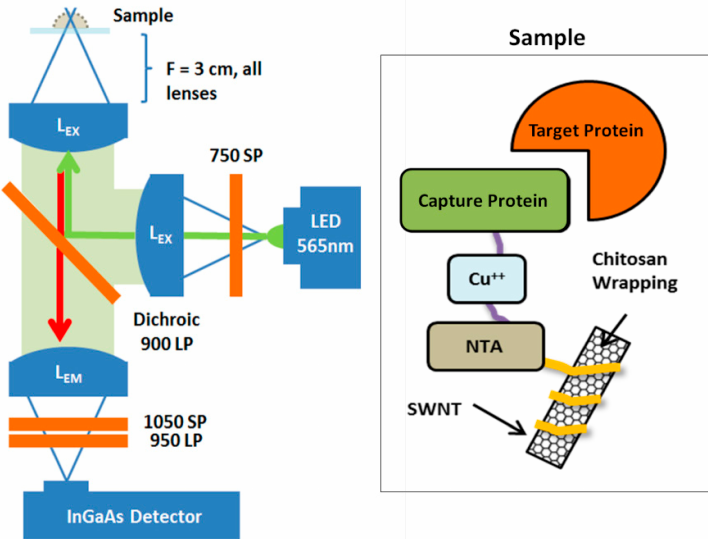
Figure 5. Inverted microscope designed to capture changes in SWCNT sample near-infrared intensity from the sample plane. This protable design allows label-free real-time detection of bioanalytes. Binding of the target protein ( orange ) to the capture protein ( green ) modulates the SWCNT near-infrared emission, captured by the